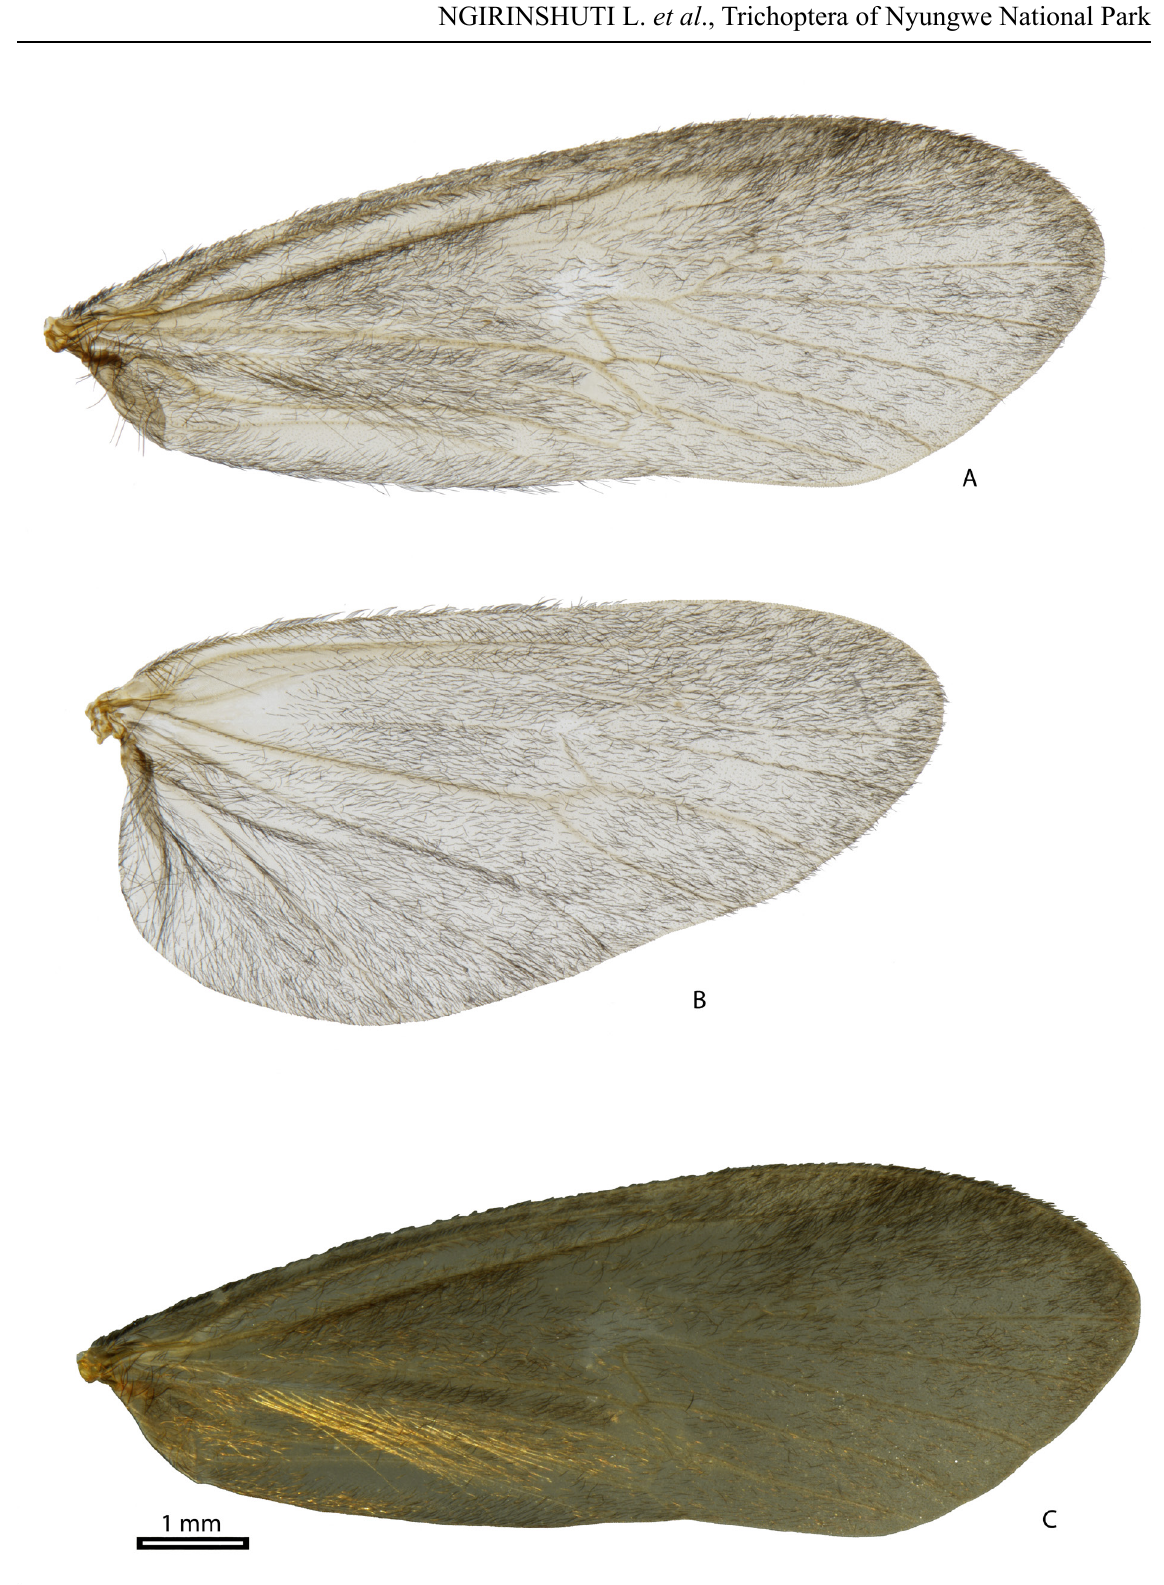
Fig. 4. Silvatares laetae Ngirinshuti & Johanson sp. nov., ♂, holotype. A . Right forewing. B . Right hind wing. C . Right forewing, underside, showing long golden hairs. Scale bar = 1